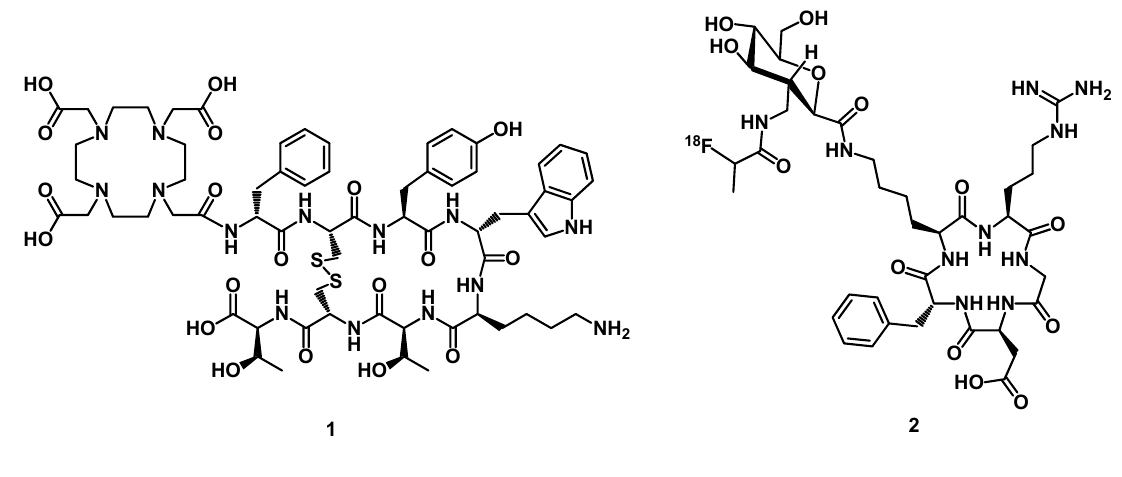
Figure 2. Chemical structures of DOTA-TATE and [ 18 F]Galacto-RGD, two typical radiolabeled peptide